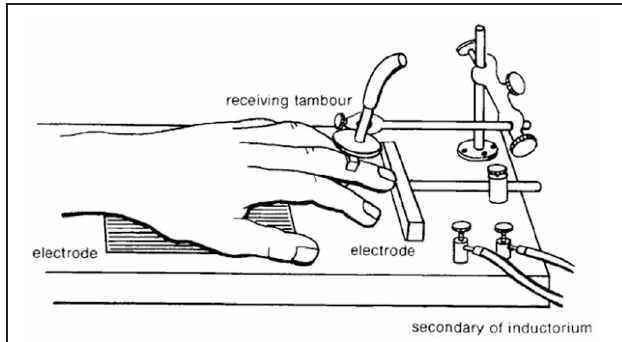
FIGURE 1 | Illustration of the first conditioned avoidance (initially described as a conditioned reflex) experiment conducted in America by John B Watson. Electrodes were placed under the hand and finger of a human subject. An auditory stimulus was presented prior to the delivery of electrical shock. A recording device allowed for the detection of finger movements evoked by the shock and the preceding auditory stimulus. Within a few trials, finger withdrawal began to occur to the auditory stimulus. The conditioned finger withdrawal broke the circuit between the two electrodes, which was necessary for the delivery of electric shock. Originally published in Watson